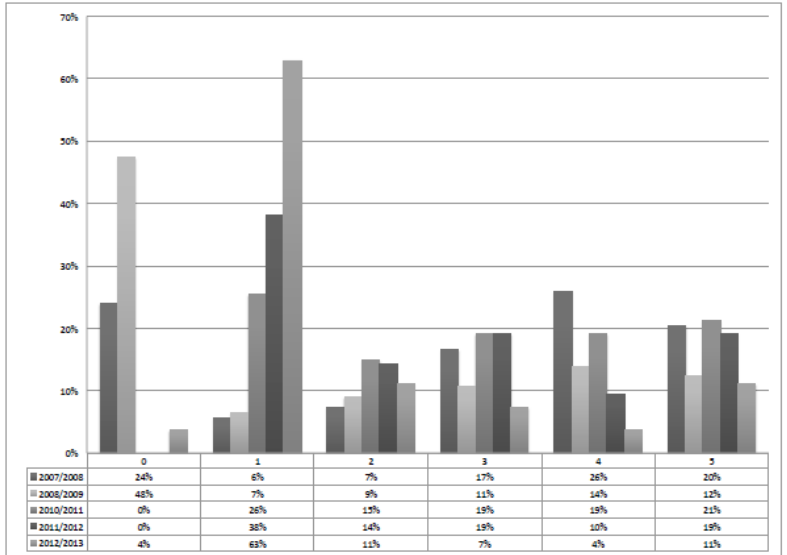
Figure 6. You have used the JavaVis Desktop framework to do lab